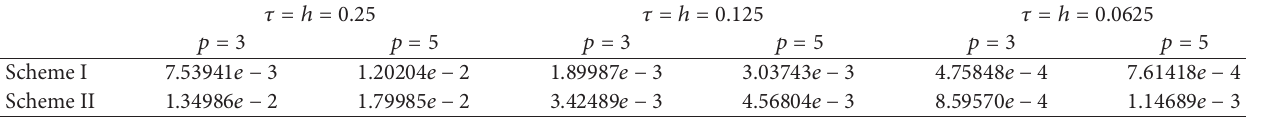
Table 2: The error comparison when 𝑡 = 40 .